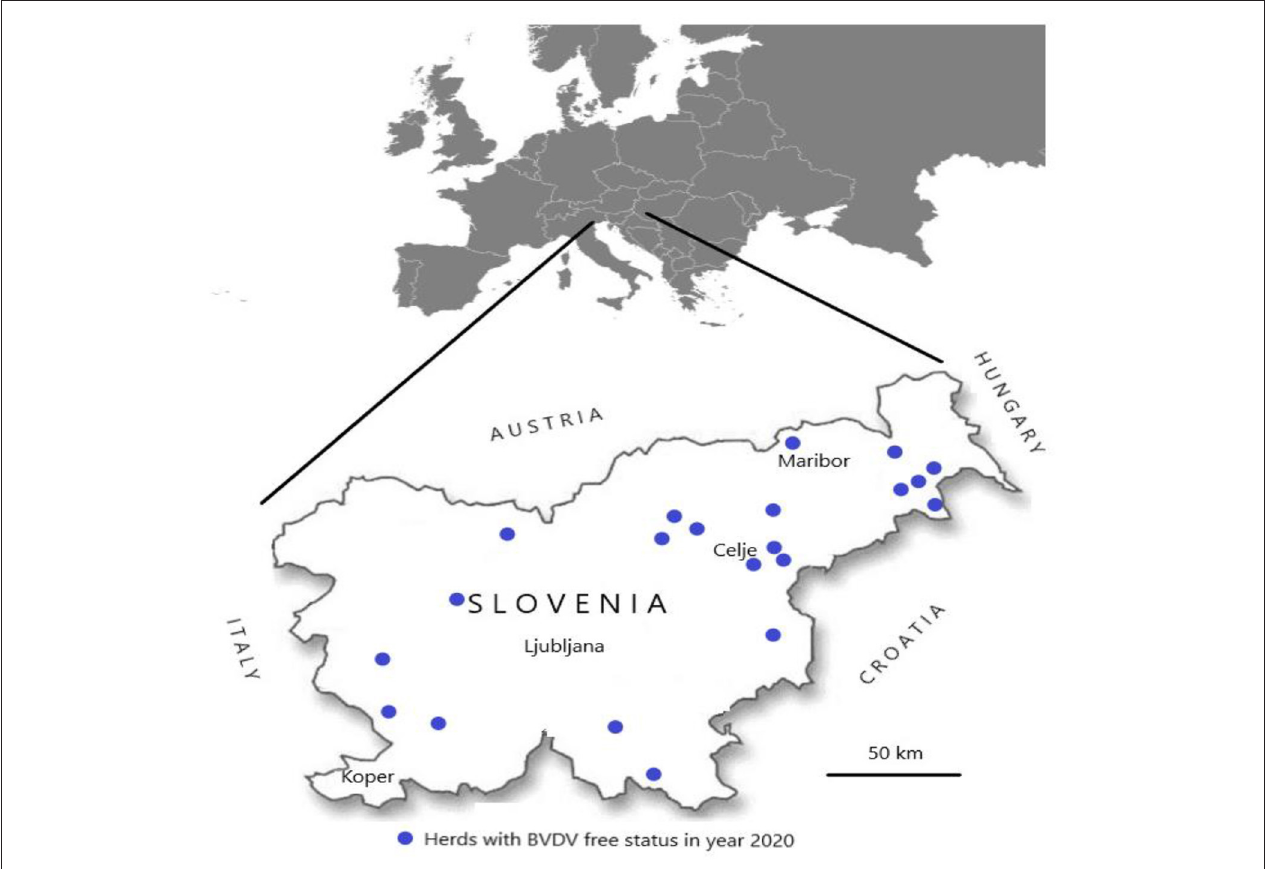
FIGURE 3 | Locations of 21 herds with BVDV free status in 2020, presented on map of